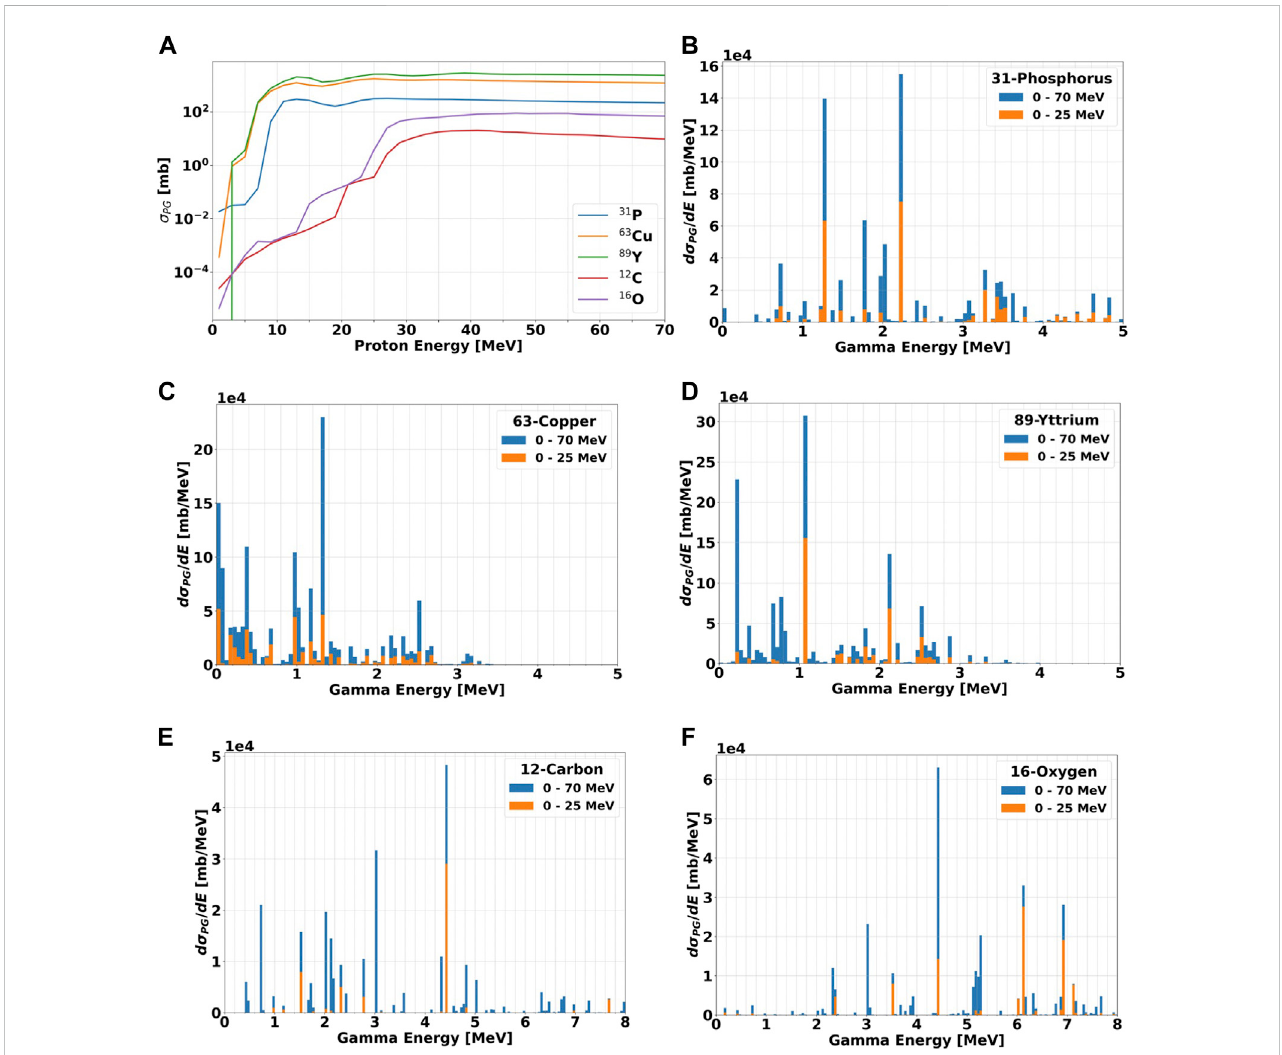
FIGURE 5 (A) :Totalproductioncrosssection σ PG forPGsofallenergiesasafunctionoftheincidentprotonbeamenergy.Thedataareshowforthethreecandidate elements ( 31 P, 63 Cu, and 89 Y) and the most abundant nuclei in the human body ( 12 C and 16 O). The proton energy step is set to 1 MeV. (B – F) : differential cross sections inenergy d σ PG / dE fortheproductionofPGsasafunctionoftheirenergyfor allmaterialswhenirradiatedwithprotonsintheenergyranges0 – 25and 0 – 70 MeV.Thedatawerecalculatedbysummingupallgammasofagivenenergyproducedinthematerialanddividedbythebinwidthof0.05 MeV.All calculations have been performed with